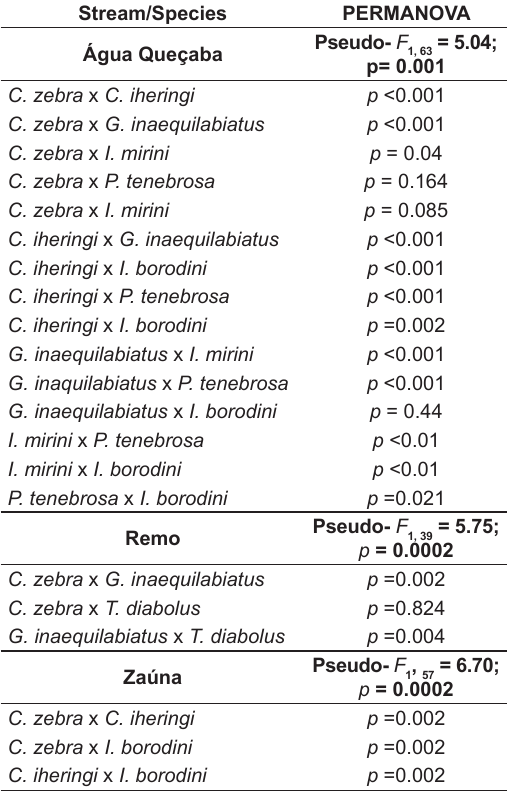
Table 2. Results of permutational multivariate analysis of variance (PERMANOVA) applied to diet data of fish species sampled in three streams located in the Pirapó River basin (Upper Paraná River,